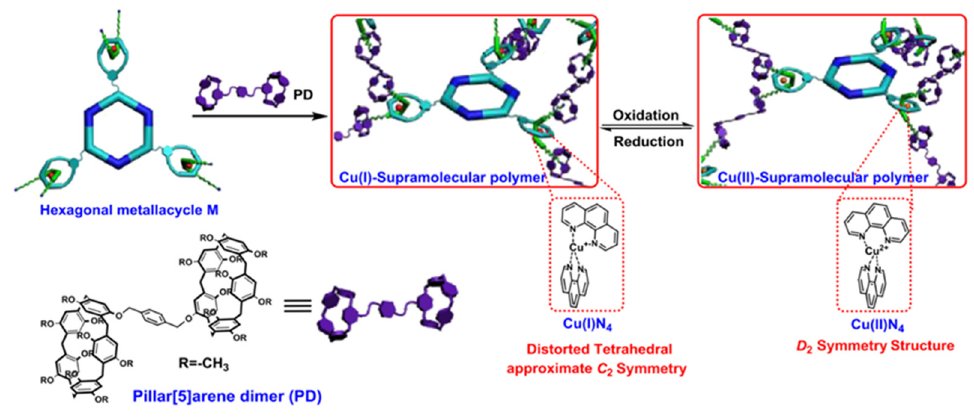
Figure 36. Schematic of the synthesis and redox behavior of the supramolecular polymer (reproduced with permission of American Chemical Society from ref. [121]).